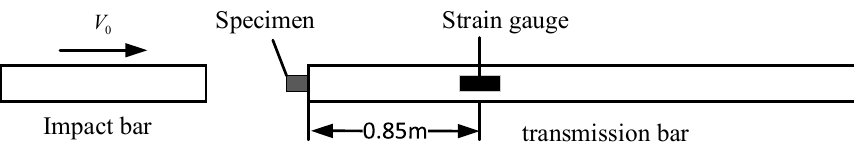
Figure 3. Split Hopkinson Pressure Bar (SHPB) test system with measurements.